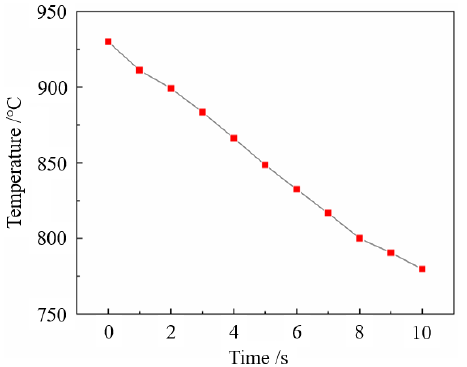
Figure 11. Temperature variation of 22MnB5NbV at air cooling rate from 930 °C.